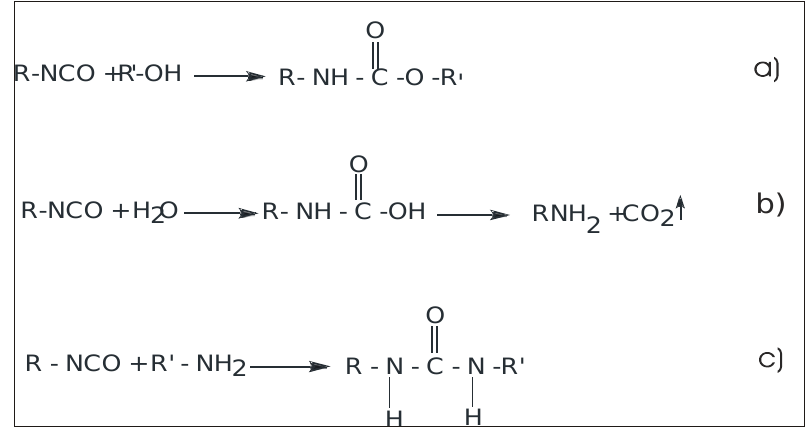
Figure 1 . Isocyanate reactions with alcohol (a) and with water